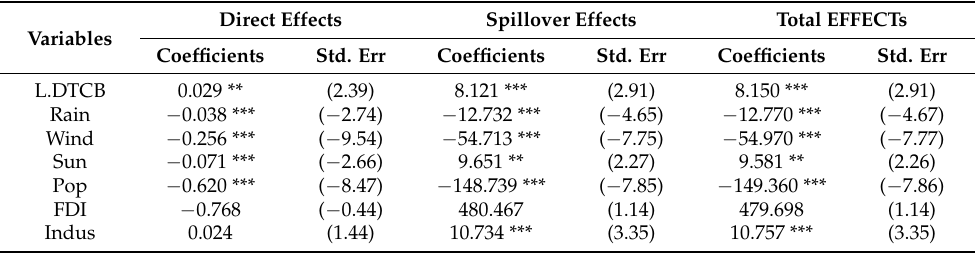
Table 8. Robust test with the first order lagged value of Fintech.